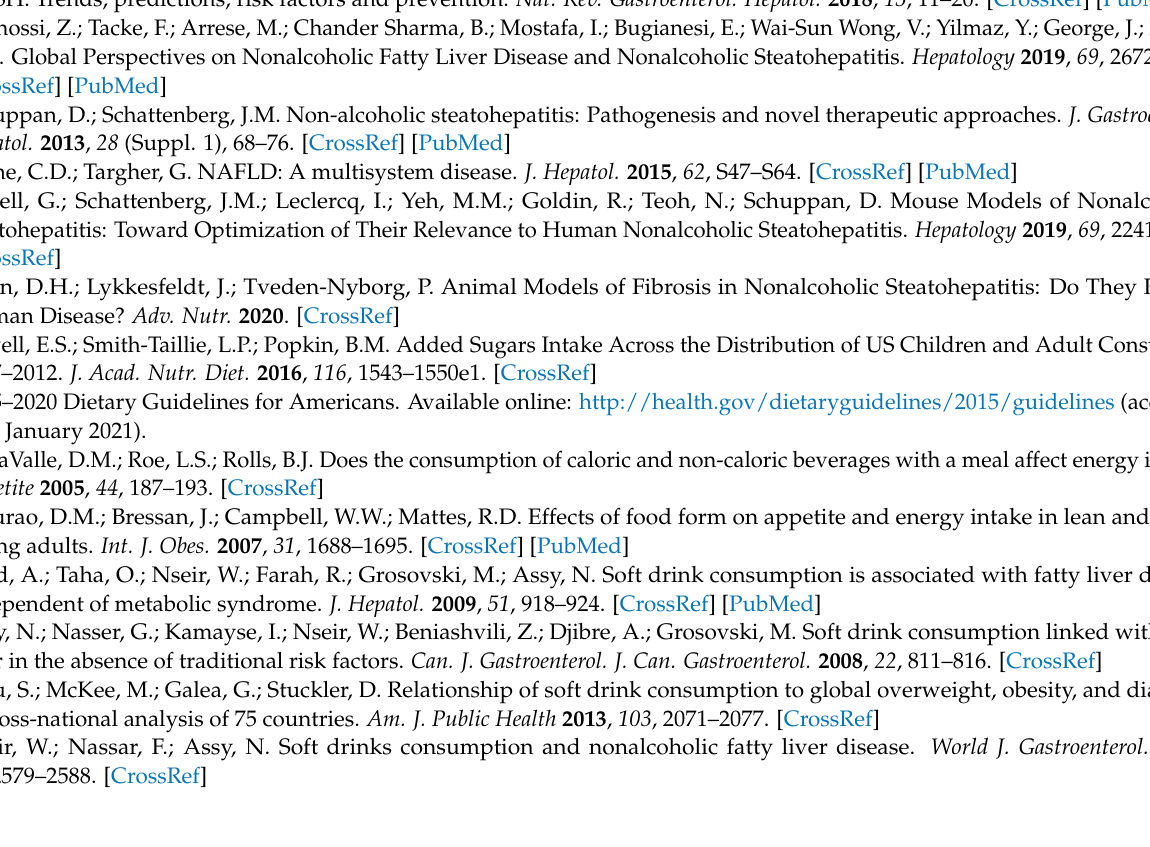
test, Figure S3: Correlation of body weight and triglyceride content in the LF-HSt group, Table S1: Major dietary components listed in %, Table S2: Detailed list of dietary components, Table S3: Total plasma and liver vitamin C levels corrected for food intake, Table S4: Liver TG levels upon exclusion of steatotic animals, Table S5: Plasma biochemical markers at week